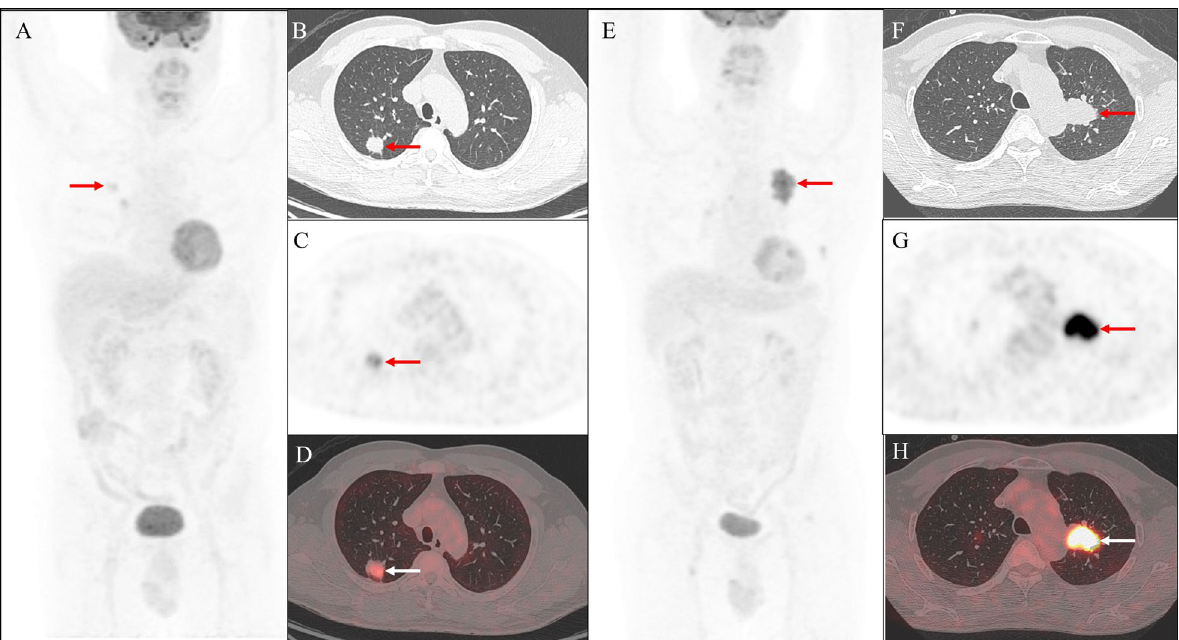
Fig. 3 Representative PET/CT images of male patients with EGFR mutation and EGFR wild-type. A – D A 54-year-old male patients with lung ADC and normal concentrations of serum CYFRA21-1 (0.7 ng/mL) and SCC-Ag (0.58 ng/mL). Three-dimensional maximum intensity projection (3-D MIP) PET images ( A ), axial CT ( B ), PET ( C ), and fusion PET/CT images ( D ) showed a mild increase in 18 F-FDG uptake of primary lesion (SUV max 6.09) in the right upper lung (arrows). E – H A 63-year-old male patients with lung ADC and increased concentrations of serum CYFRA21-1 (10.97 ng/mL) and SCC-Ag (4.12 ng/mL). 3-D MIP PET images ( A ), axial CT ( B ), PET ( C ), and fusion PET/CT images ( D ) showed a significantly increase in 18 F-FDG uptake of primary lesion (SUV max 14.75) in the left upper lung (arrows)